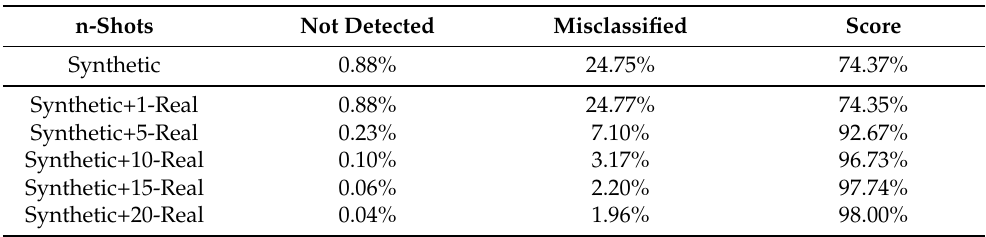
Table 8. Application-oriented metric results comparing purely-synthetic training with few-shot fine-tuning against the controlled dataset {5}